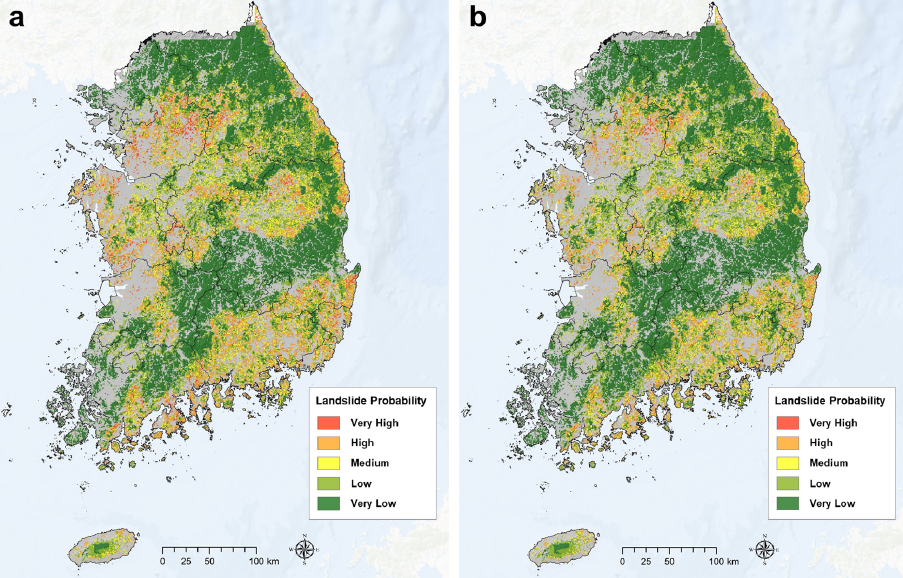
Figure 7. Landslide probability of 2092: ( a ) only climate scenario applied, and ( b ) both climate and adaptive scenarios applied.